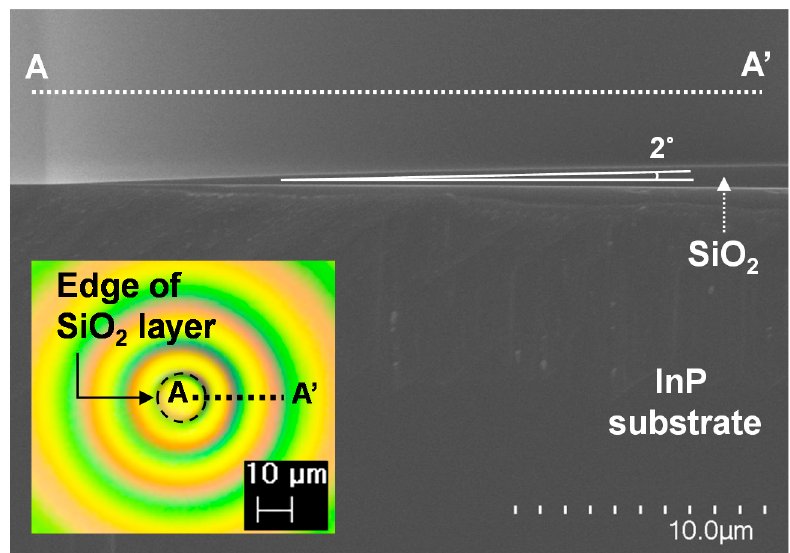
Figure 8. SEM image near a sidewall of a wet-etched SiO 2 layer patterned on InP substrate. Inset indicates a floor plan image of the patterned wet-etched SiO 2 layer by microscope. Dotted circle in the inset marks the edge of the patterned SiO 2 layer.